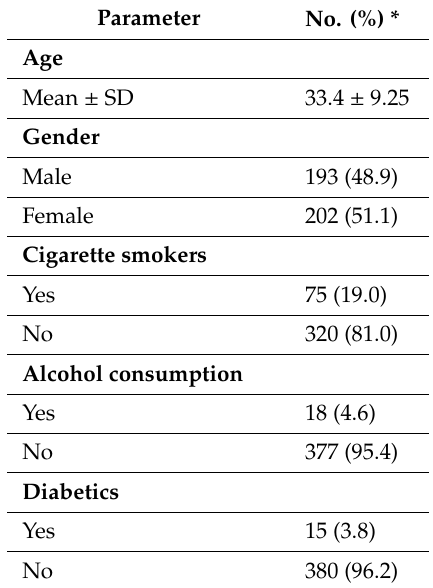
Table 1. Characteristics of the healthcare